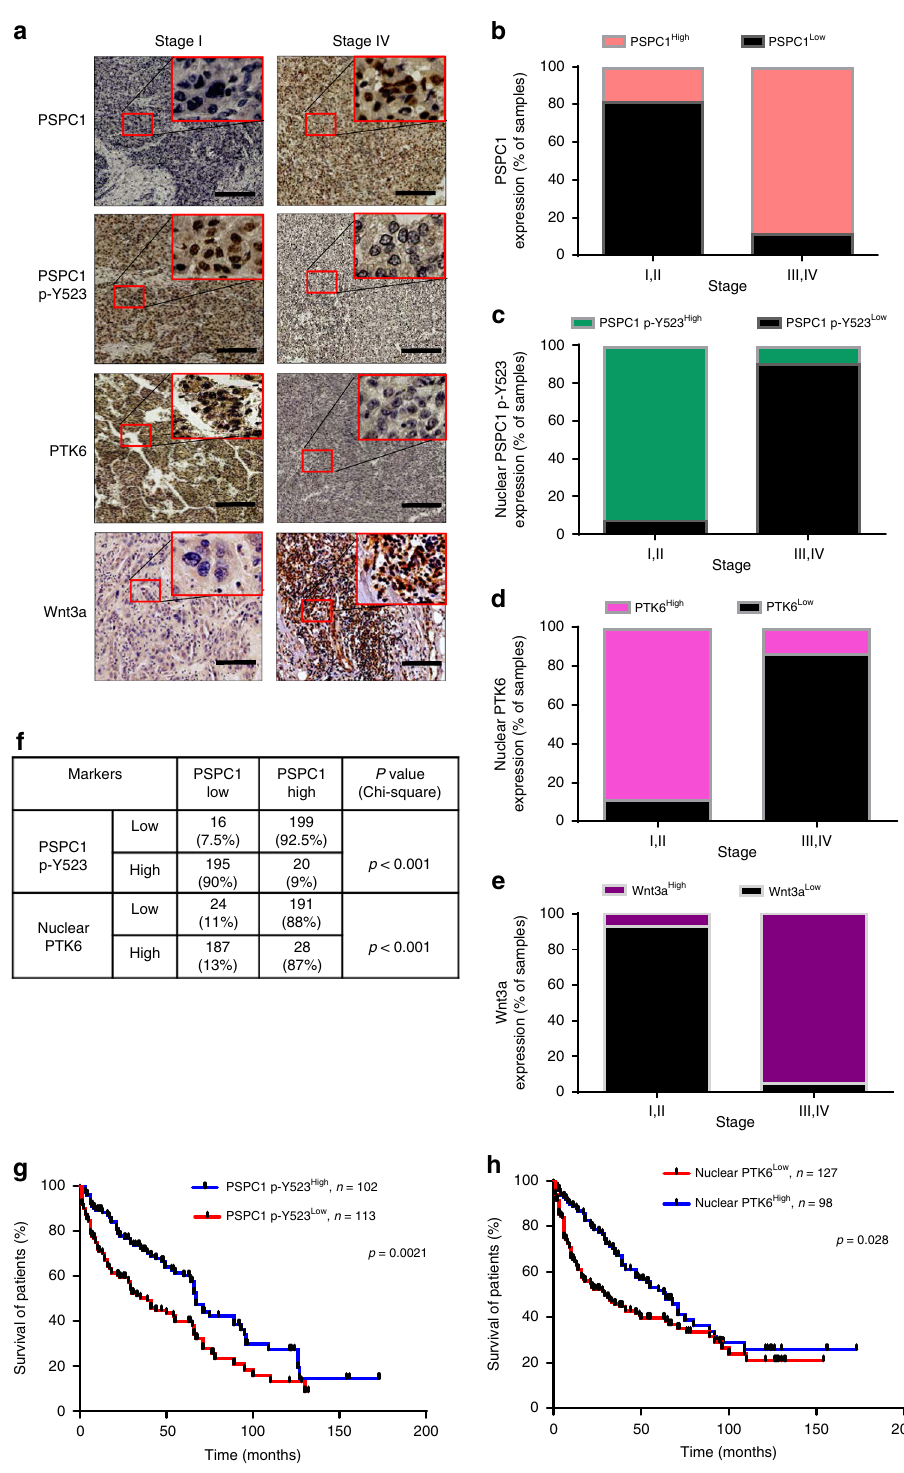
Fig. 5 Phospho-Y523 PSPC1 is associated with better prognosis of HCC. a Representative IHC staining results of PSPC1, PSPC1-pY523, PTK6, and Wnt3a expression in stage I (left panels) and stage IV (right panels) human HCC tissues. A large red tangle shows the enlargement areas is placed on the top right corner of each IHC image. The scale bar represents 50 µ m. b – e Expression percentage of PSPC1 (red color for higher expression), phosphorylated Y523 PSPC1 in the nucleus (green color for higher expression), nuclear PTK6 (pink color for higher expression) and Wnt3a (purple color for higher expression) staining in early (I and II) and late stage (III and IV) tumors in human HCC tissues. Data are shown as the mean percentage of samples, n = 215. f The relationship between PSPC1 expression and the expression of PSPC1 phospho-Y523 and nuclear PTK6 in human HCC tissues. g , h Kaplan – Meier plot analysis of the overall survival of 215 HCC patients based on low or high expression levels of PSPC1-pY523 ( g ) and nuclear PTK6 ( h ). The p value was determined by the Gehan – Breslow – Wilcoxon test. Source data are provided as a Source Data fi